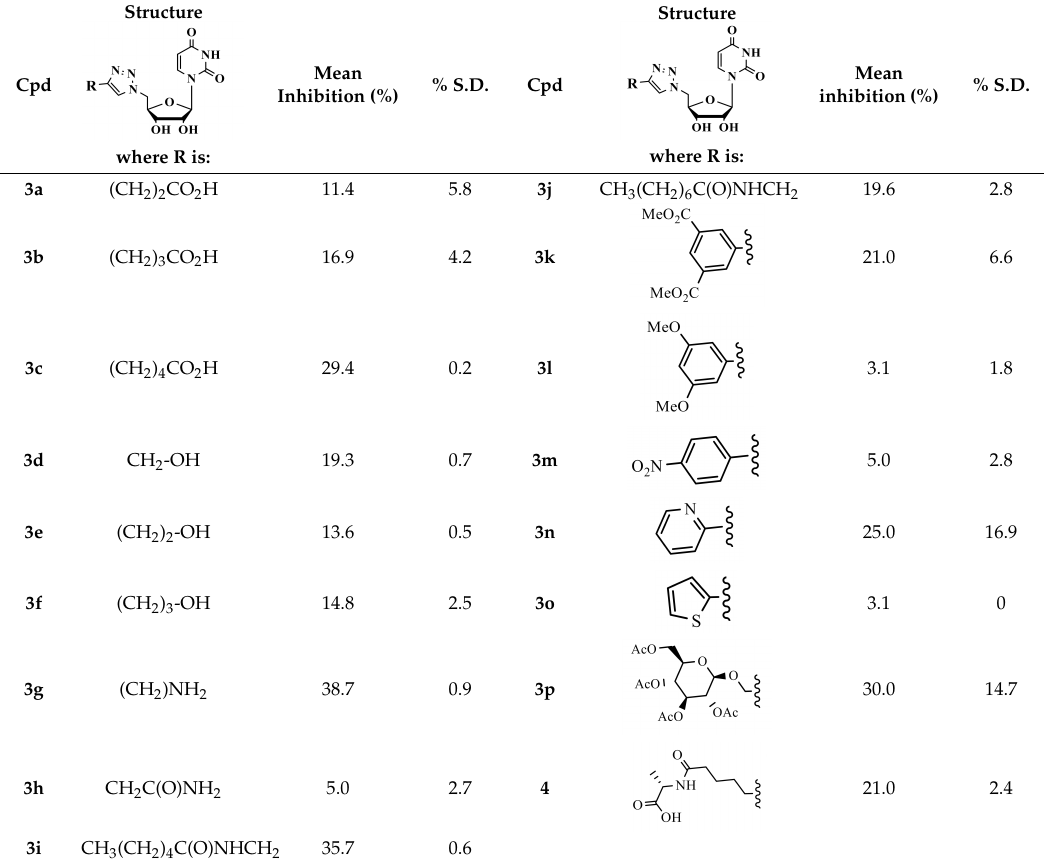
Table 1. Results of the inhibition of one-pot assay containing Mtb MurA-F enzymes by compounds 3a – p and 4 at 100 µ